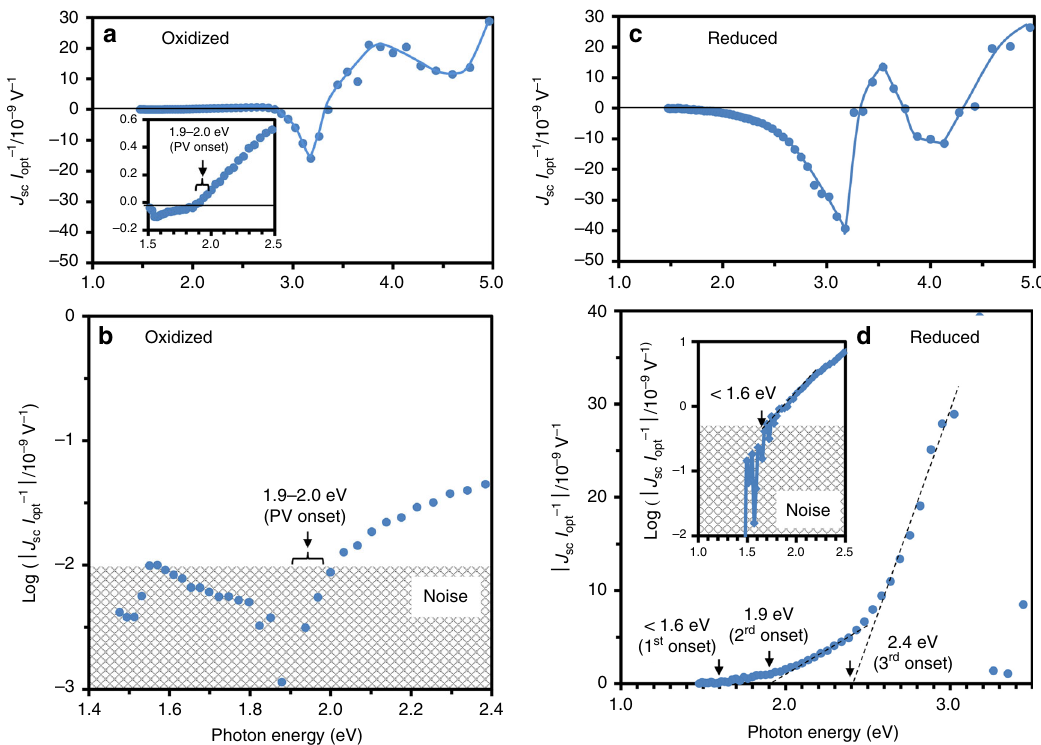
Fig. 6 Photovoltaic currents versus photon energy. The short-circuit current density ( J sc ) normalized by optical intensity ( I opt ) is plotted as a function of photon energy ( hv ) for the a , b oxidized and c , d reduced samples. The valence state of iron in the oxidized sample is Fe 3 + as the majority, while that in the reduced sample is a mixture of Fe 2 + and Fe 3 + . The fi rst PV onset is determined as the threshold by considering the noise level and the strong emissions of Xe lamp (light source) in the near-infrared range. The oxidized sample displays the fi rst PV onset at 1.9 – 2.0 eV. The reduced sample exhibits a multiple-PV process: the fi rst PV onset appears at less than 1.6 eV followed by the second at 1.9 eV and the third at 2.4 eV.